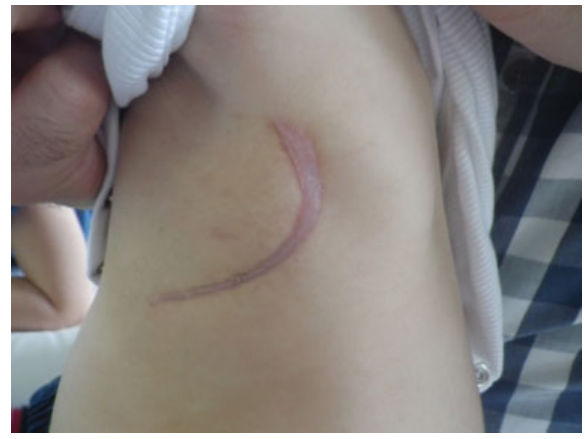
Fig. 2 Intraoperative site after incision.